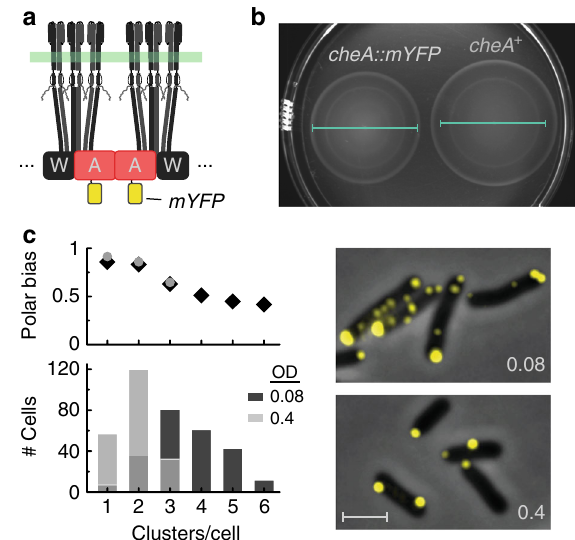
Fig. 1 Basic characterization of the MG1655/ cheA::mYFP (MK4) cells. a Schematic description of core complexes showing the position of the mYFP tag in the core complex. b Colony expansion of the MG1655 (CheA + ) cells and the cheA::mYFP derivative in soft agar chemotaxis plates after 10 h at 30 °C. Bars are of the same size. c Fluorescence images of cheA::mYFP cells grown to an optical density (OD 600 ) of 0.08 or 0.4 in liquid culture. Scale bar corresponds to 2 µ m. Histogram of the number of clusters per cell in the two populations (240 and 209 cells, respectively) and the respective polar bias of the clusters (number of polar clusters / total number of clusters) in each subpopulation of cells belonging to each bin of the histogram are also